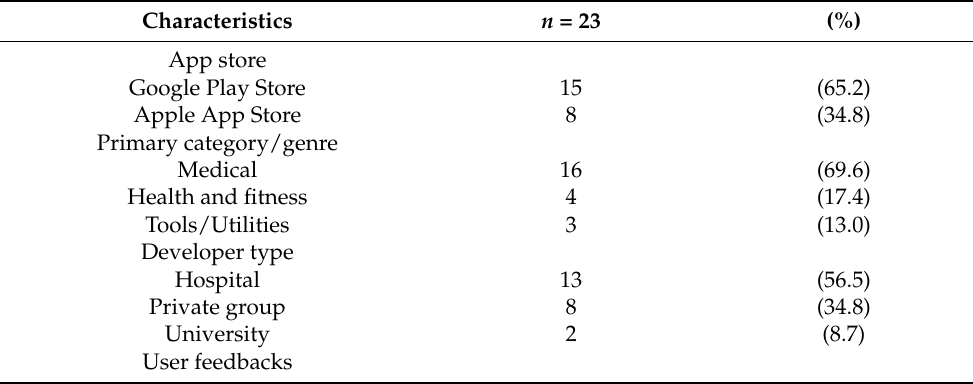
Table 1. Characteristics of drug reference apps in Taiwan. ( n = 23, Taiwan,